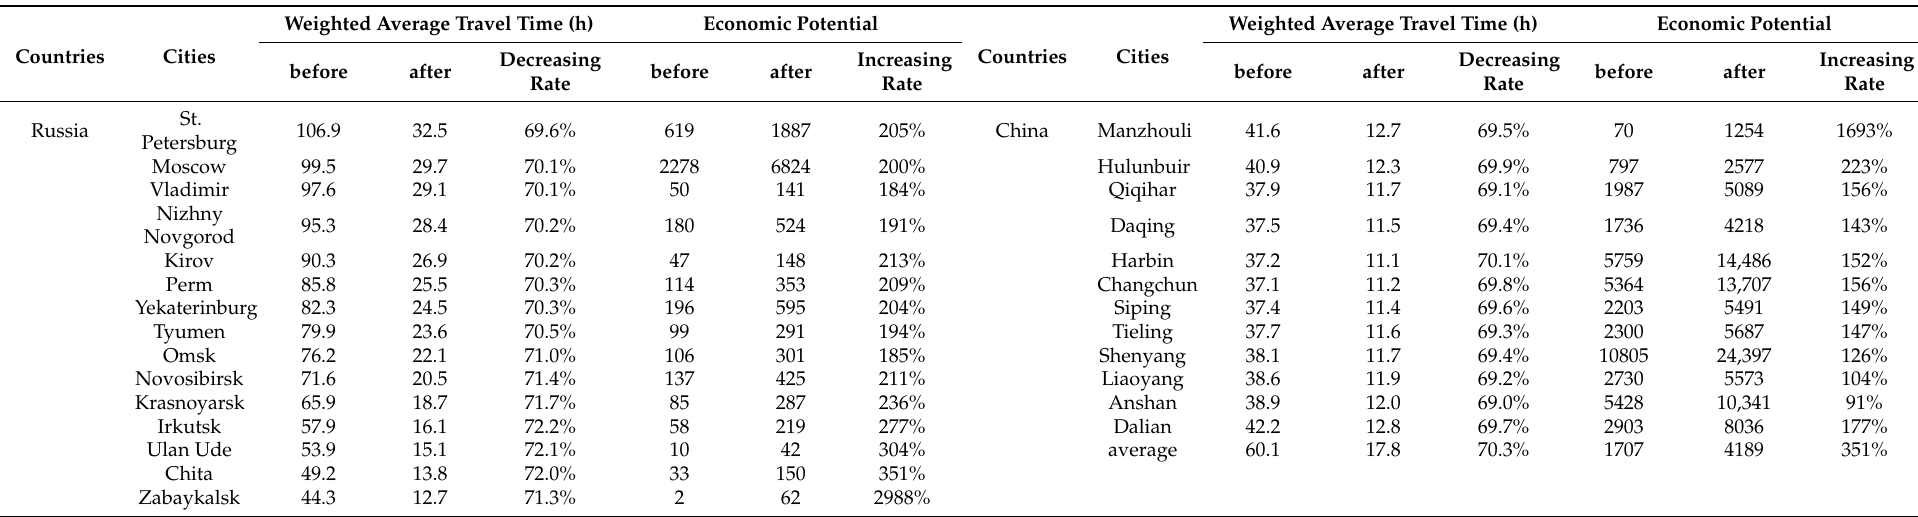
Countries Cities